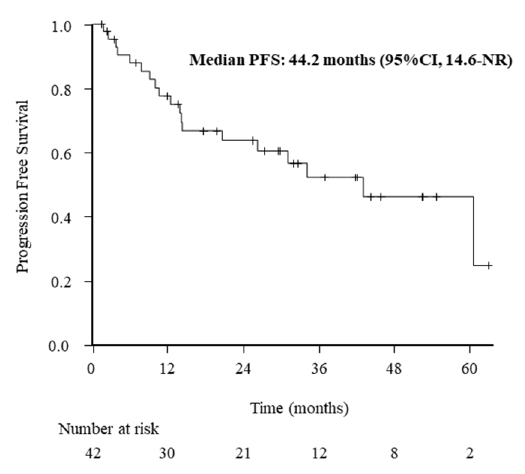
Figure 1. Kaplan–Meier curve of progression-free survival (PFS) in all patients. The median PFS was 44.2 months (95% confidence interval: 14.6 months, not reached).